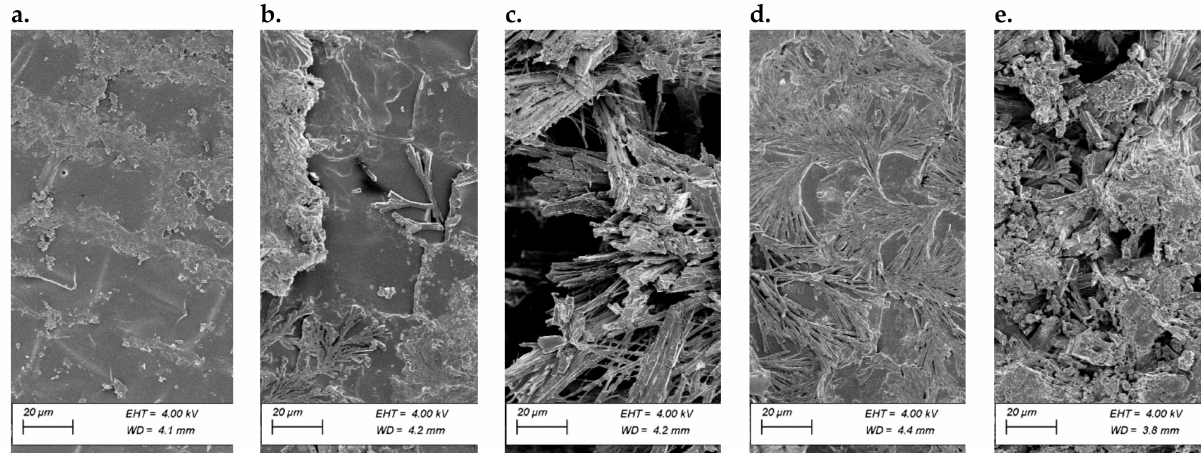
Figure 3. SEM microscopic image of the surface morphology after modification with different concentrations of the AA ( a ) S1—reference sample, ( b ) S5.1 sample, ( c ) S5.2 sample, ( d ) S5.3 sample, ( e ) S5.4 sample; InLENS (S1—Uncoated seeds, S5.1—Seed coating containing a solution of 2% alginate with amino acids (37.6 mL/100 g), micronutrients (37.5 mL/100 g), and NPK, S5.2—Seed coating containing a solution of 2% alginate with amino acids (75.1 mL/100 g), micronutrients (75.1 mL/100 g), and NPK, S5.3—Seed coating containing a solution of 2% alginate with amino acids (112 mL/100 g), micronutrients (112 mL/100 g), and NPK, S5.4—Seed coating containing a solution of 2% alginate with amino acids (150 mL/100 g), micronutrients (150 mL/100 g), and NPK).